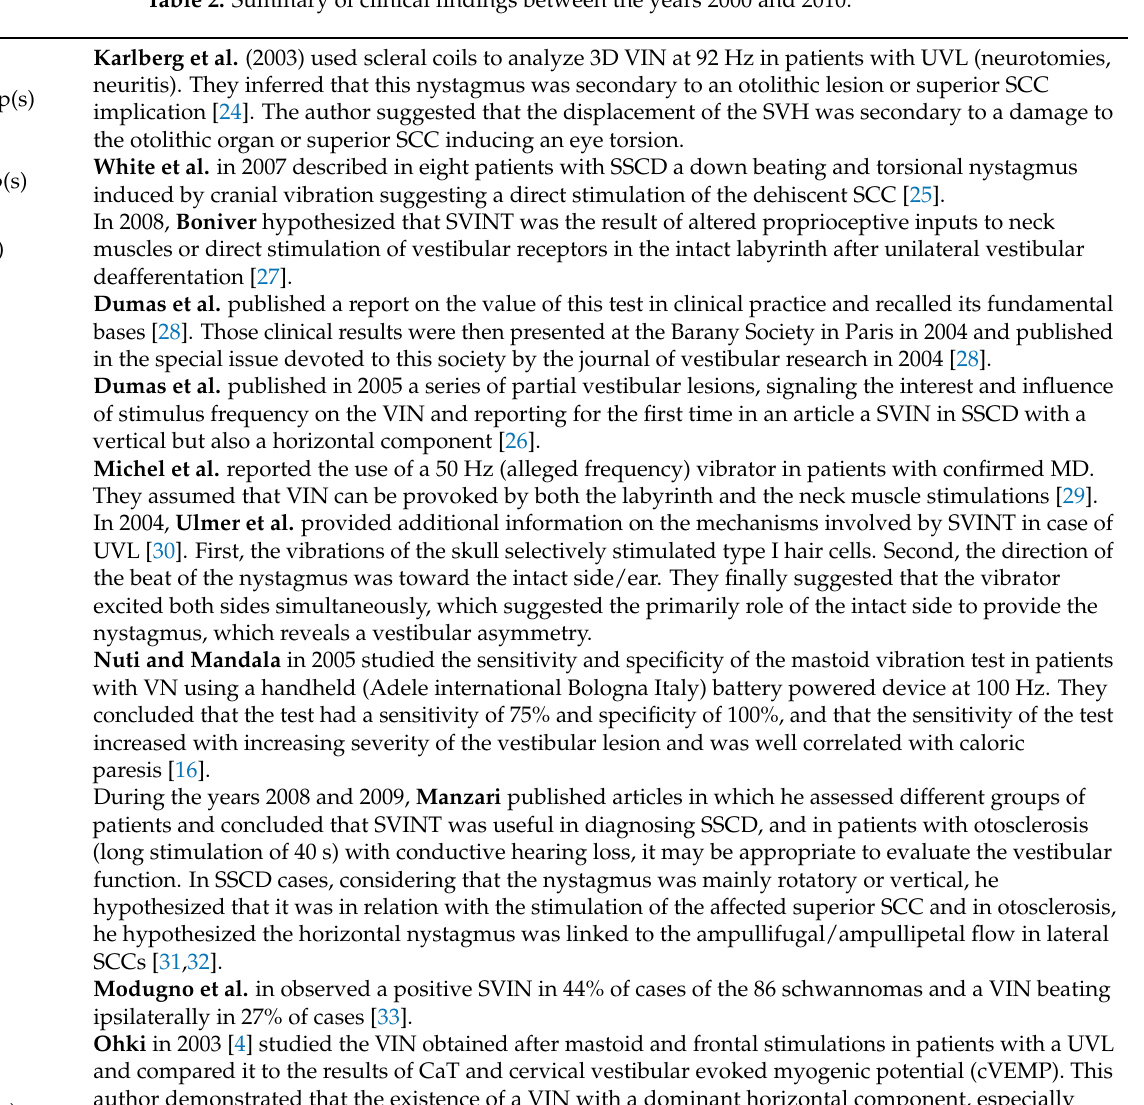
Table 2. Summary of clinical findings between the years 2000 and